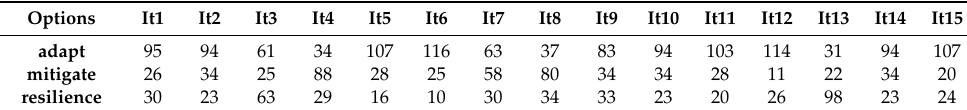
Table 3. Responses of CC actors in Benin.